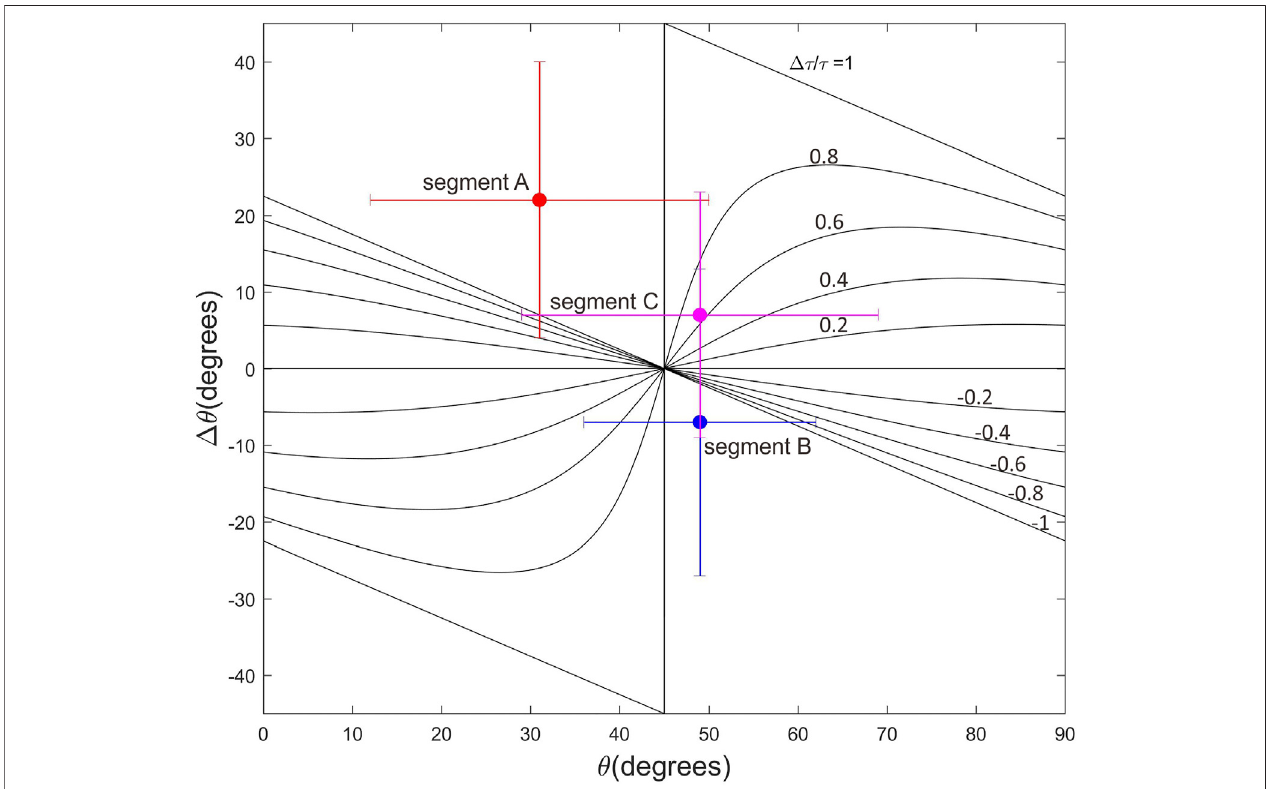
FIGURE 9 | Plot of stress rotations in the three segments analysed in this study, where θ is the pre-mainshock angle of σ 1 axis to the orientation of the megathrust interfaceand Δθ isthestressrotationbetweenthepre-vspost-mainshock.ThetheoreticalstressdropratiofollowingHardebeckandHauksson(2001)foreachsegment is plotted. Bars plotted along with the theoretical stress drop is the uncertainty estimated as half the 95% con fi dence intervals (see Table 3 ).